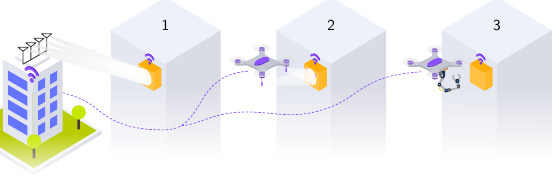
Figure 1. Overview of different solutions: (1) uncoupled wireless power transfer, (2) wireless charging by UAV equipped with WPT transmitter in proximity of the IoT node, and (3) battery replacement by